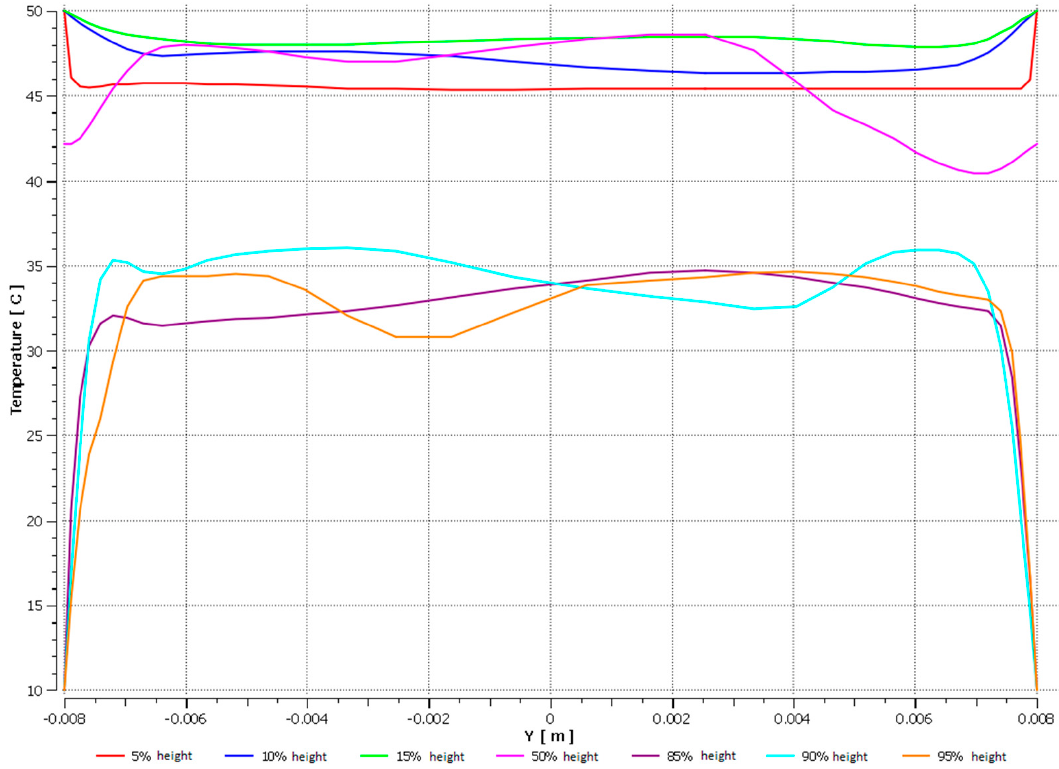
Figure 10. Temperature distribution along the cross-section.